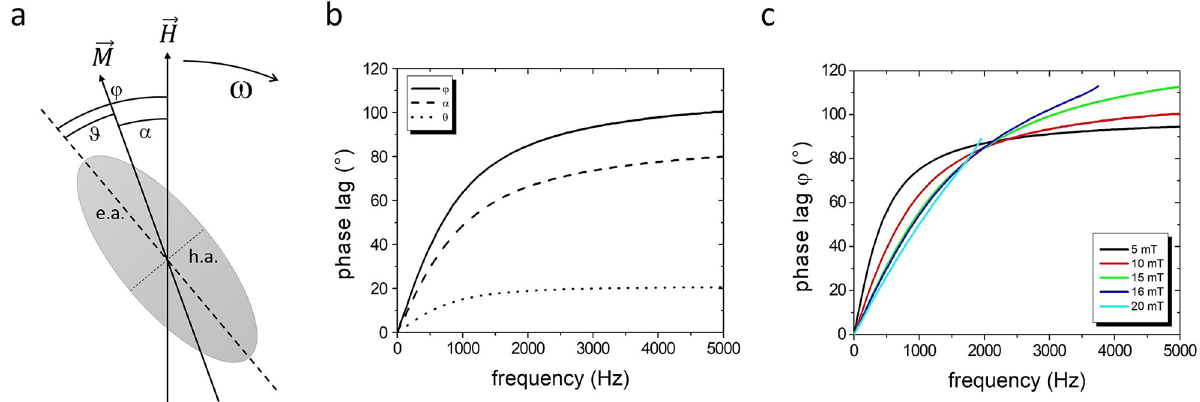
Figure 2. ( a ) Sketch of a rotating nanoparticle with relevant angles. ( b ) Calculated phase lag φ (measured), α (viscous) and from Eqs. (2) and (4) for a 400 nm x 200 nm elliptical nanoparticle with a NiFe layer of 7 nm and a total thickness of 60 nm in water (η = 0.001 Pa s) at room temperature for H = 10 mT. The saturation ϑ moment of NiFe is 88 emu/g, the anisotropy field 30 mT, and the hydrodynamic dimensions are increased by a factor 3. ( c ) Optically measurable phase lag φ for different field